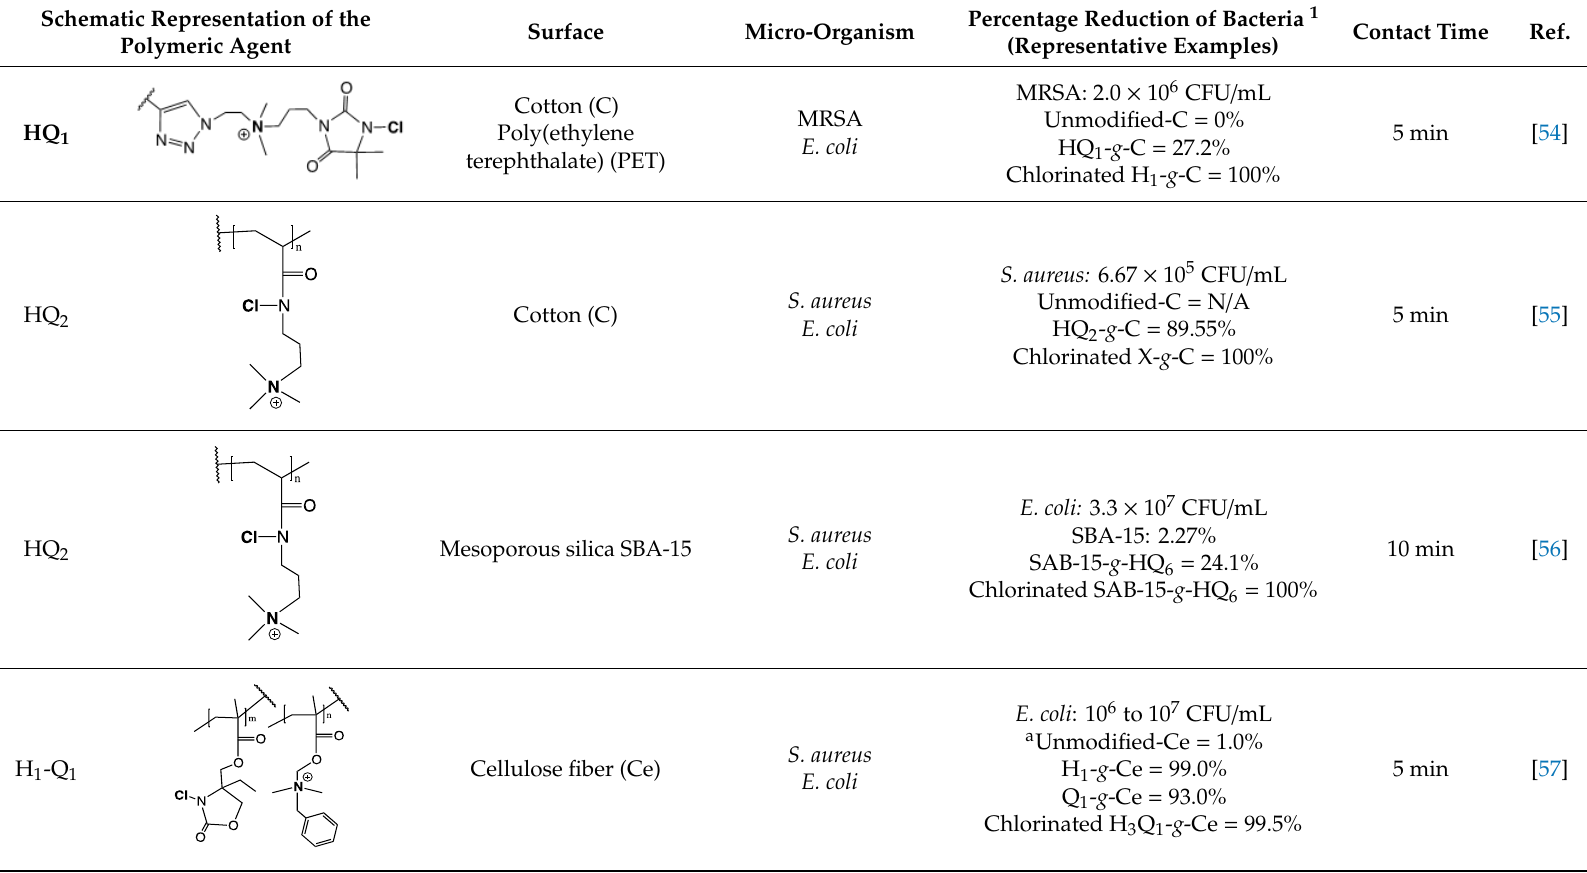
Table 1. Antimicrobial investigations of systems containing N -halamines and quaternary ammonium salts (QAS) moieties attached to di ff erent surfaces.